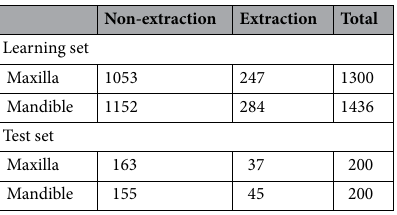
Table 1. The characteristics of the photographs used in this study.